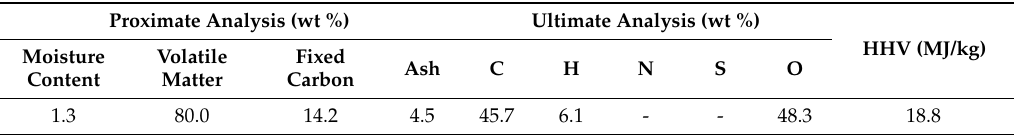
Table 4. Proximate and ultimate analysis of the oak wood biomass. Higher heating value (HHV) estimated using work by Sheng and Azevedo [63]. “-” indicates that the concentration was below the level of